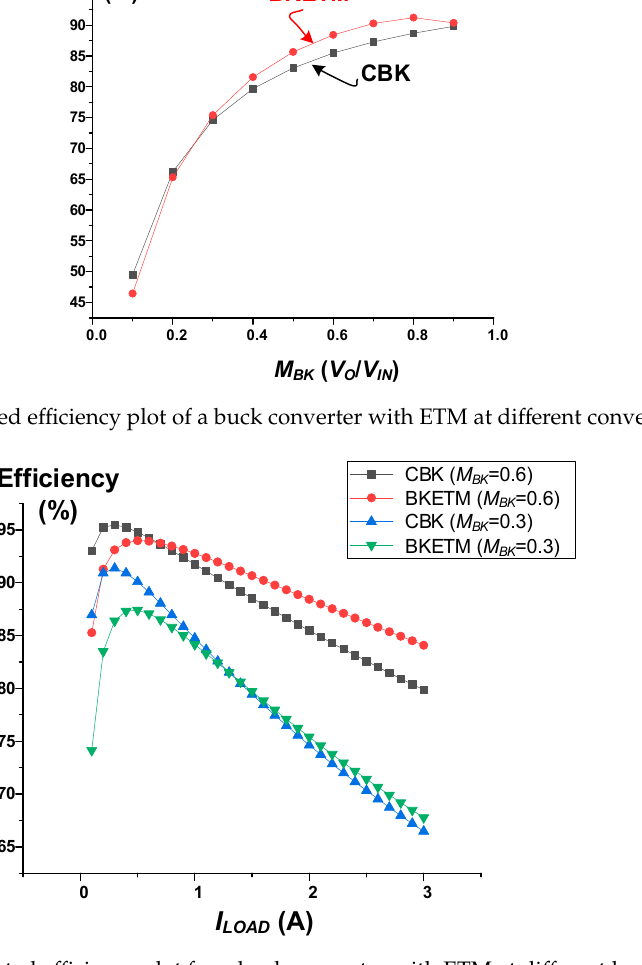
Figure 14. Simulated efficiency plot for a buck converter with ETM at different load currents.